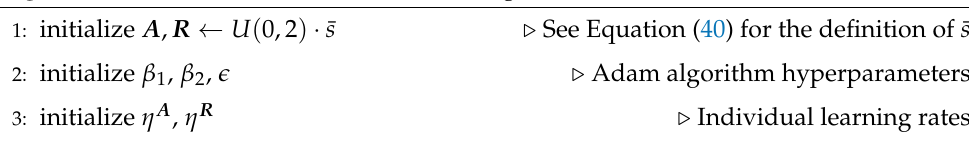
Algorithm 1 The row-stochastic DEDICOM algorithm